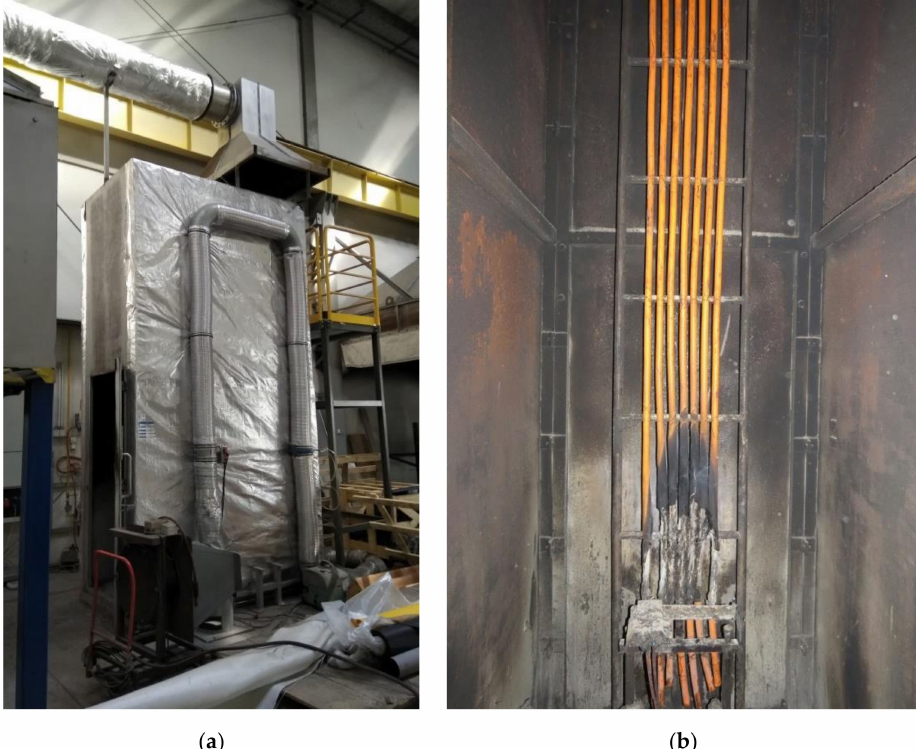
Figure 9. EN 50399 standard test apparatus at the ITB Fire Laboratory, Poland: ( a ) test chamber; ( b ) specimen No 4 after the test (numbering according to Table